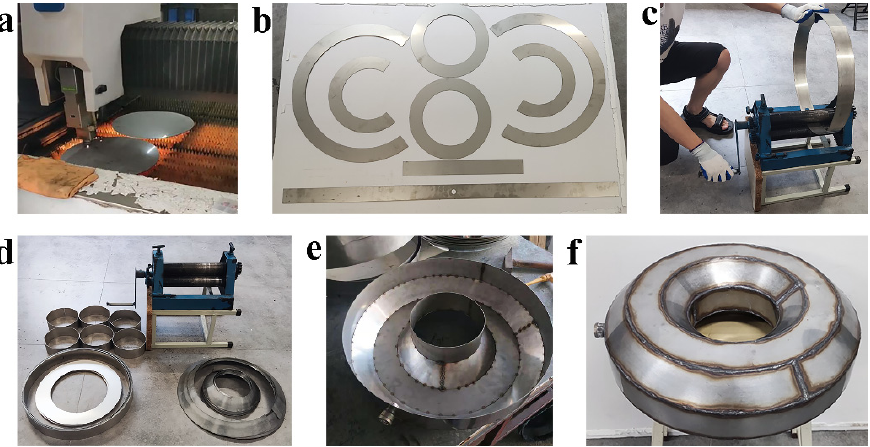
Figure 11. Manufacturing flowchart of toroidal pressure hull with discrete octagonal cross-section: ( a ) blank cutting, ( b ) cut blank inspecting, ( c ) cut blank bending, ( d ) bent blank inspecting, ( e ) bent blank assembling, and ( f ) bent blank welding.